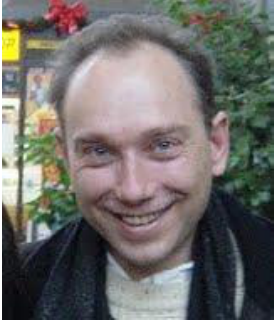
Figure A6. Klaus Johannsen.